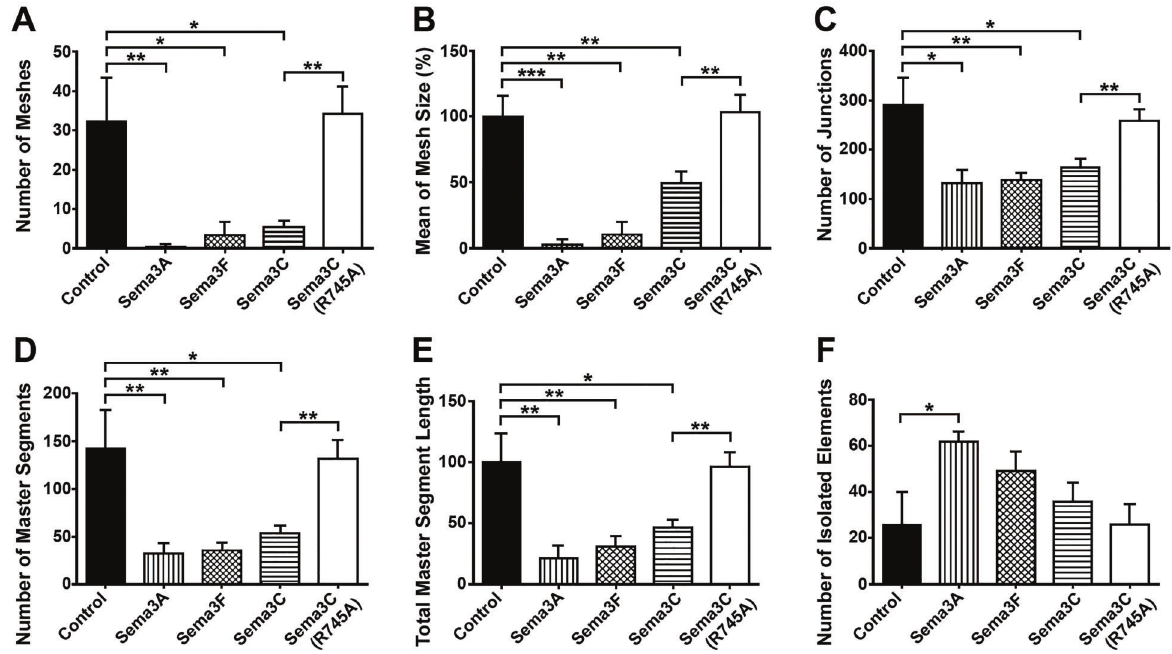
Figure 3. Analysis of microcapillary tube formation. Number of meshes ( A ), mean mesh area ( B ), number of junctions ( C ), number of master segments ( D ), total master segment length ( E ), and number of isolated elements ( F ) in Sema3A, Sema3F, Sema3C, and Sema3C (R745A) treatment and control groups. Data are reported as means ± SD. *P o 0.05; **P o 0.01; ***P o 0.001, two-tailed Student ’ s t -test.